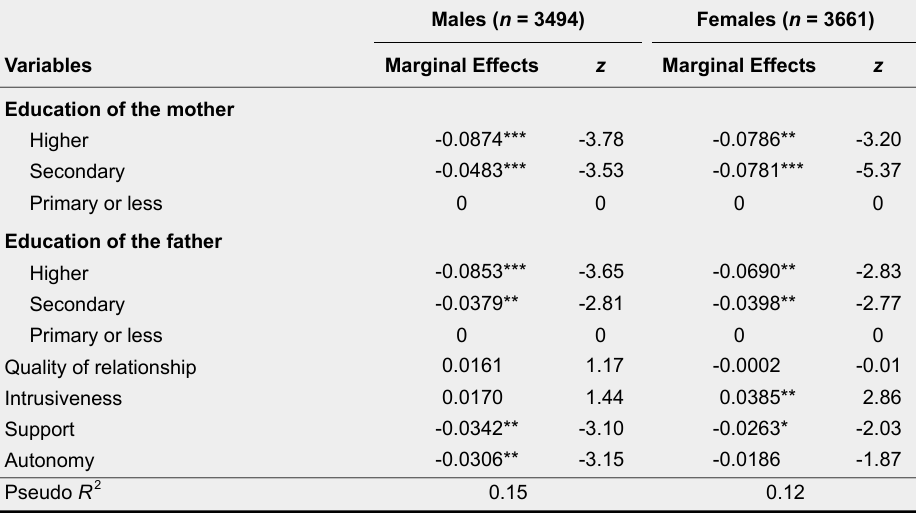
Marginal Effects for Predictors of the Condition of